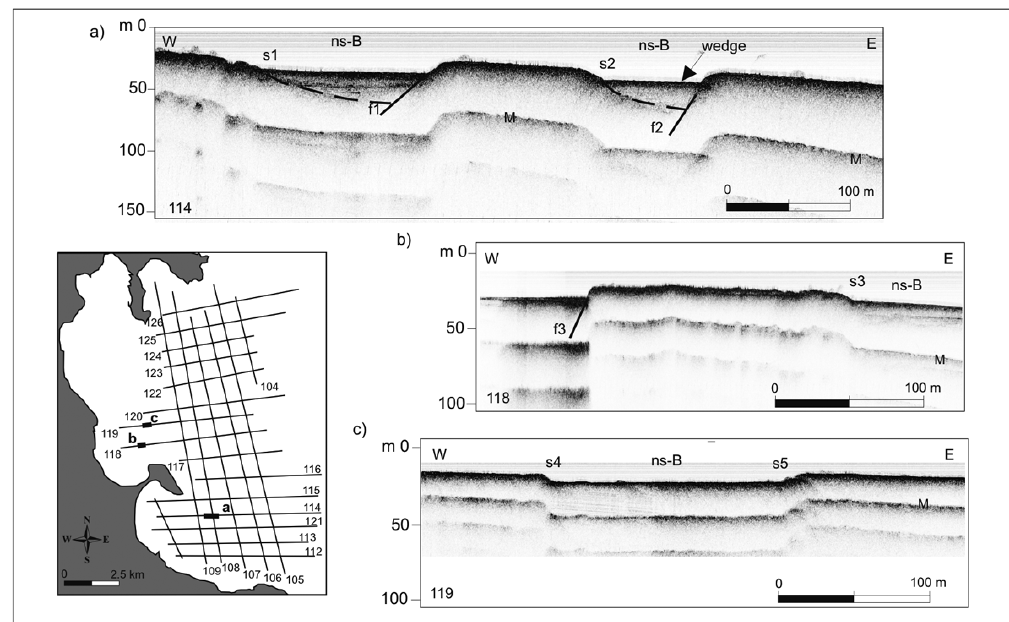
Figure 8. Location of the sections is shown in the profile grid (thick line), the line number is shown at the bottom corners; a) near shore narrow basins, ns-B, bounded by erosional scarps, s1 and s2, on the western side, and steeper, maybe younger scarps, f1 and f2, on the eastern side; b) phys- iographic high delimited by a steep scarp to the west (f3) and a more gentle and highly eroded one (s3) to the east; c) basin bounded by two highly eroded, scarps s4 and s5.